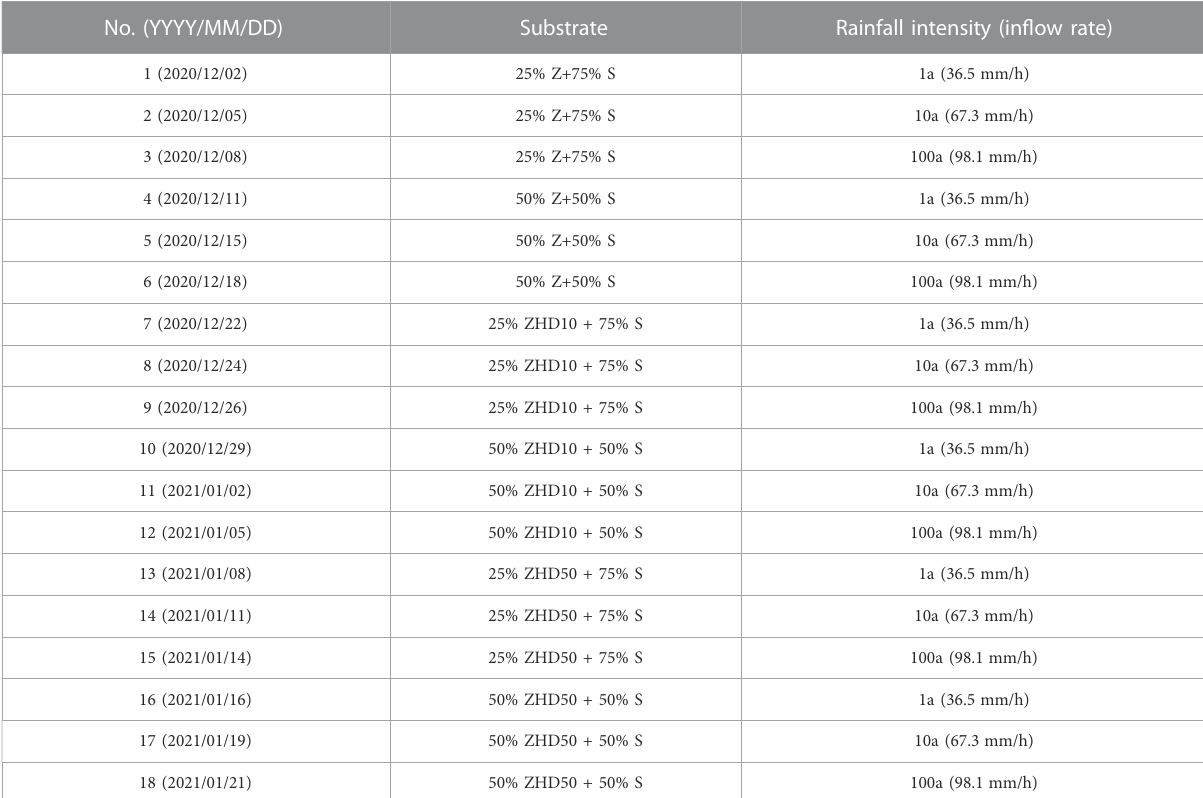
TABLE 1 Test schedule of the fi rst round of experiment. No.